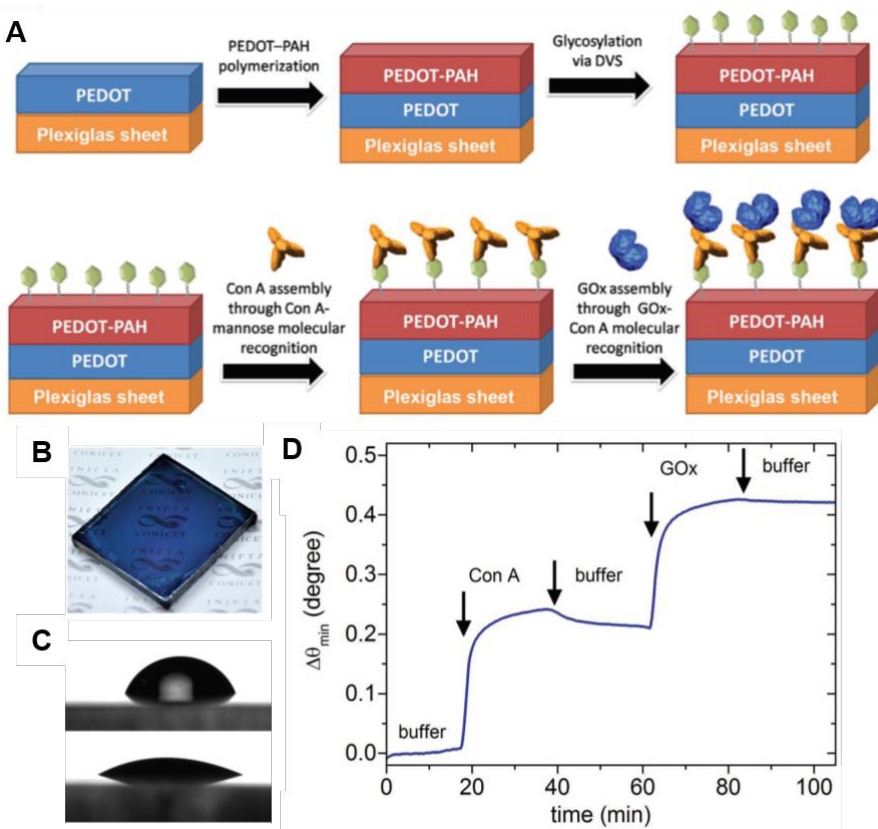
Figure 7. Scheme of the PEDOT-PAH composites preparation and biofunctionalization through mannosylation, and ConA and GOx recognition ( A ). Photograph of a Plexiglas substrate modified with the composite PEDOT-PAH ( B ). Contact angle images of PEDOT-PAH before (top) and after (down) mannosylation ( C ). SPR sensogram for the assembly of Con A and GOx on a mannosylated sensor ( D ). Adapted with permission from reference [89]. Copyright 2017 John Wiley and Sons.